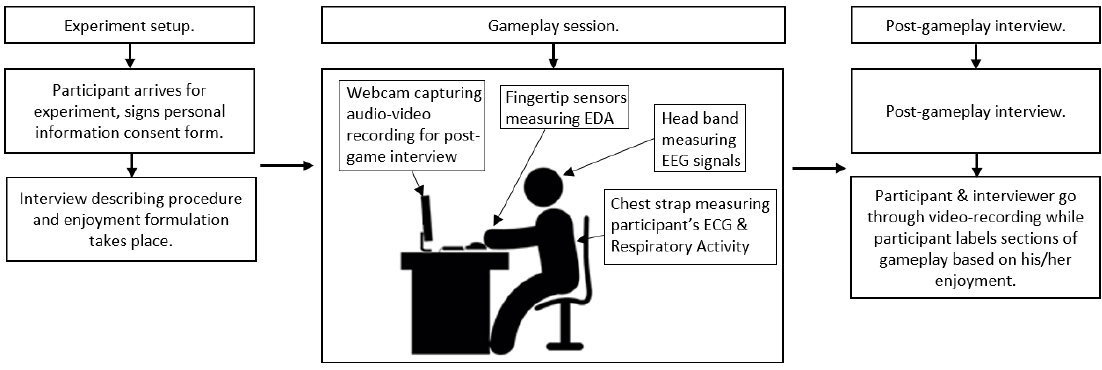
Figure 4. Schema of the experiment procedure.